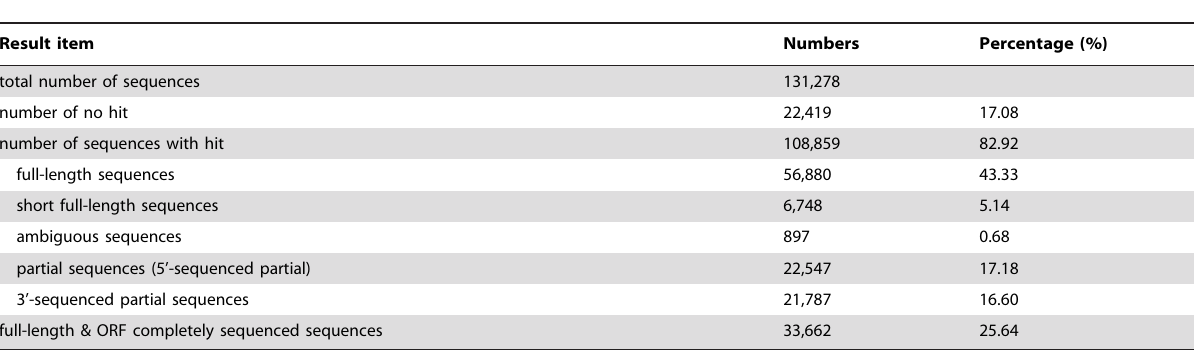
Table 2. Targetidentifier